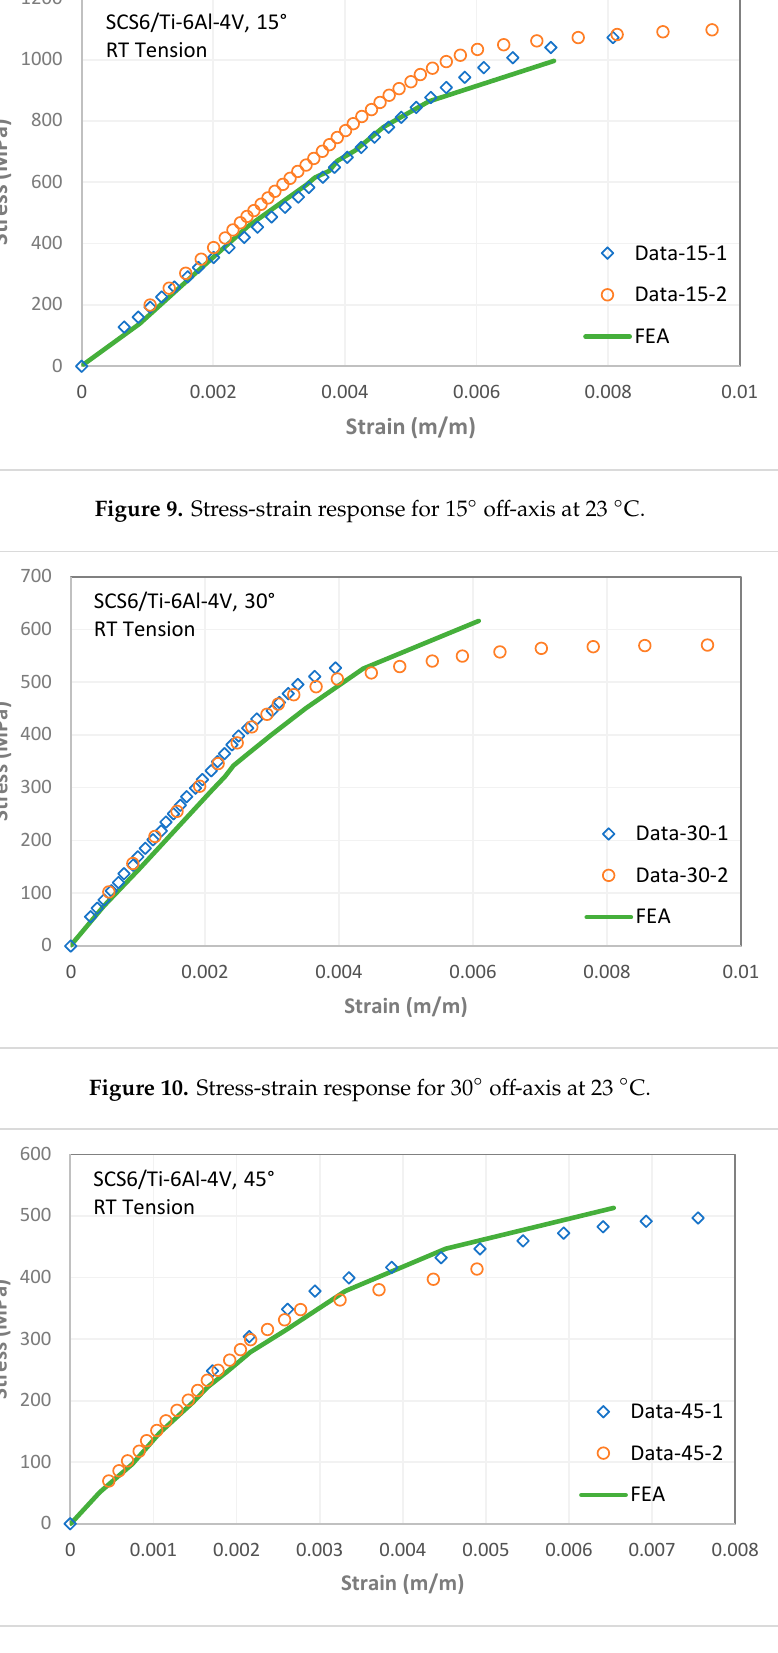
Figure 11. Stress-strain response for 45° off-axis at 23 °C.